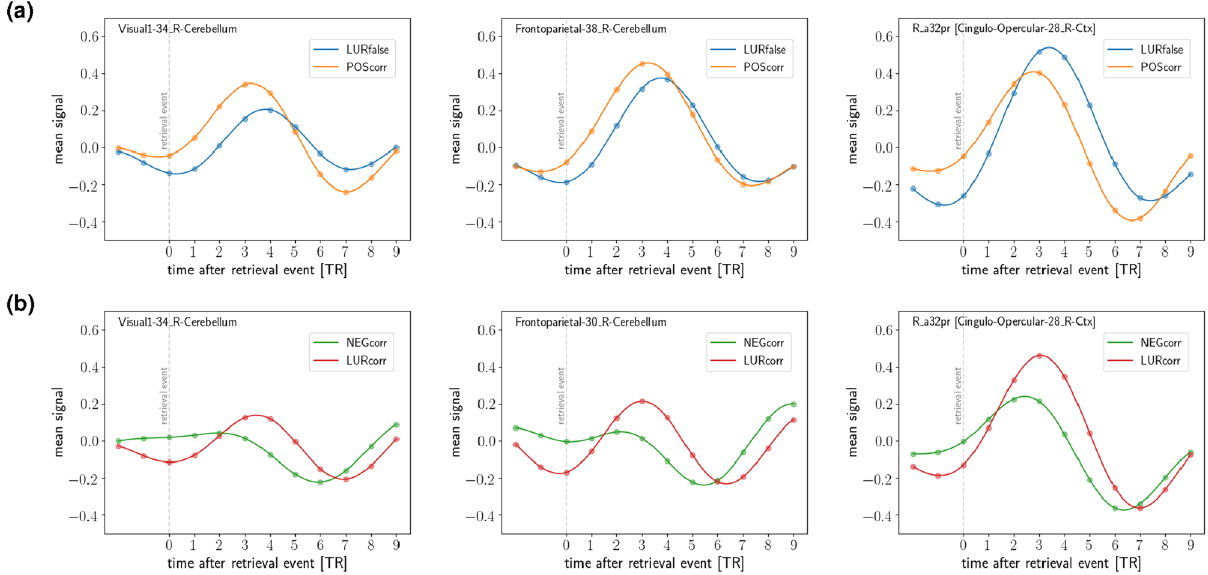
Figure 2. Differences in the course of the neural response for two contrasts (POScorr–LURfalse and NEGcorr– LURcorr). ( a ) Mean signals temporally locked to the retrieval event for POScorr–LURfalse for three selected subcortical and cortical regions. ( b ) Mean signals temporally locked to the retrieval event for lower (NEGcorr) and higher (LURcorr) levels of cognitive conflict for three selected regions, with maxima in the early time